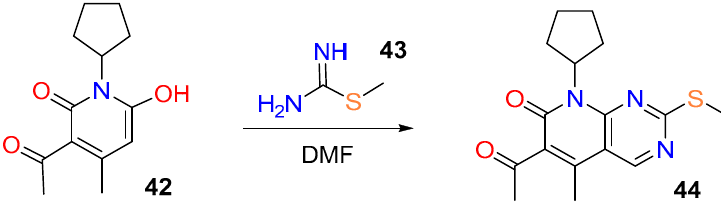
Figure 17. Synthesis of the substituted pyrido[2,3- d ]pyrimidin-7(8 H )-one ( 44 ) from the pyridone 42 .